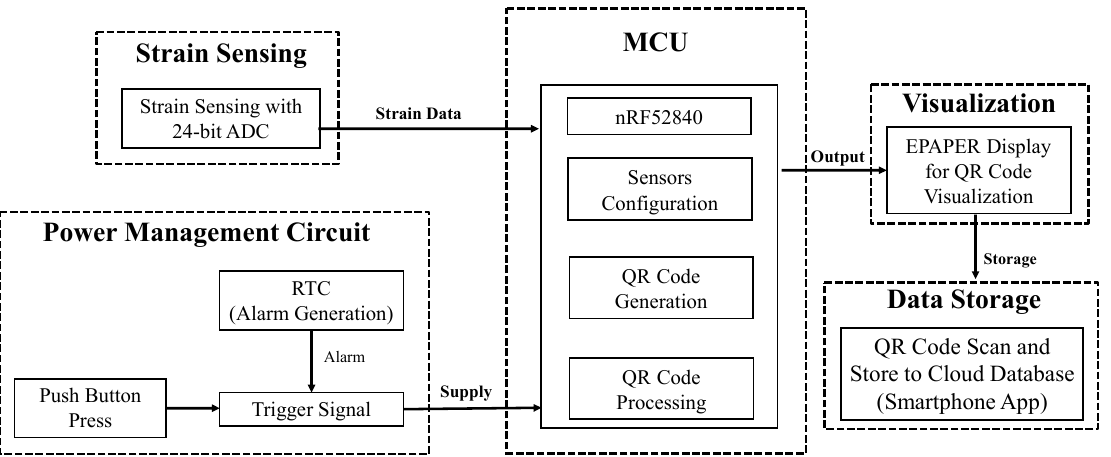
Figure 1. Block diagram of the strain sensing and visualization module (SSVM).